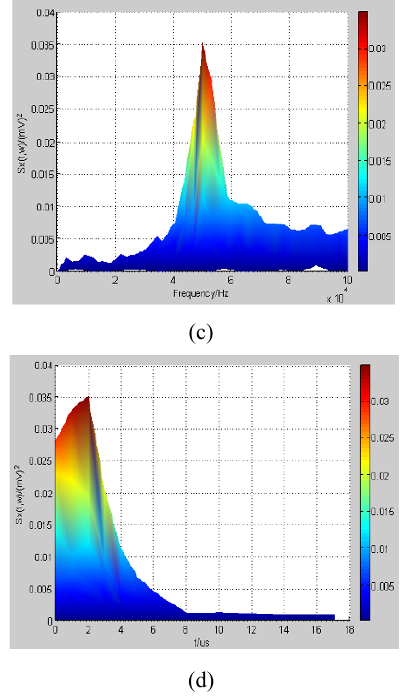
Fig. 7 Micro plasma shock wave acoustic emission signal time-frequency distribution by femtosecond laser ablation of aluminium copper alloy (90:10): (a) graphic model, (b) plan view ( x - y ), (c) front view ( x - z ), and (d) side view ( y - z ).